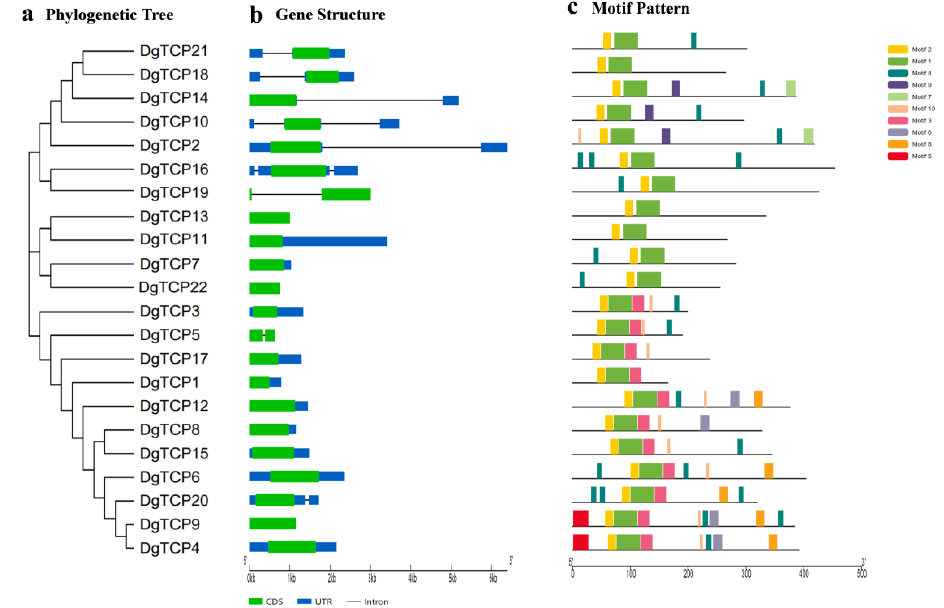
Figure 3. The phylogenetic tree of the orchardgrass TCP gene family, the gene structures, and the motifs. ( a ) The phylogenetic tree of D glomerata TCP proteins ( DgTCP ). ( b ) Exon–intron structures of DgTCP proteins. Blue squares indicate UTR, black lines indicate introns, and green squares indicate CDS. ( c ) The colored squares represent the conserved motifs of the DgTCP proteins.